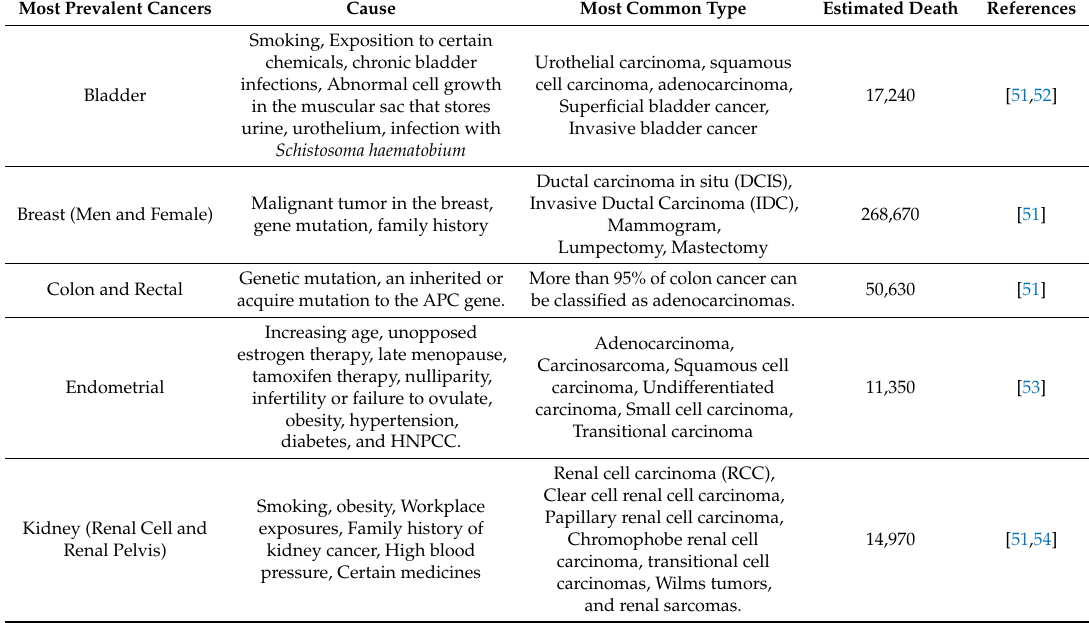
Table 2. List of cancers, their cause, common types, and estimated